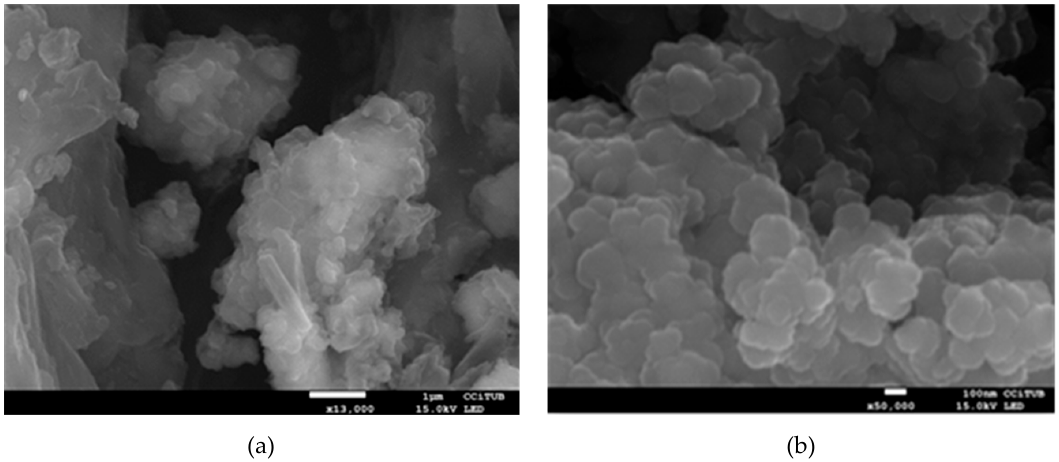
Figure 1. SEM images of the CuO nanoparticles added to the manufactured NEPCM at ( a ) 13000x magnification AND ( b ) 50000x magnification.